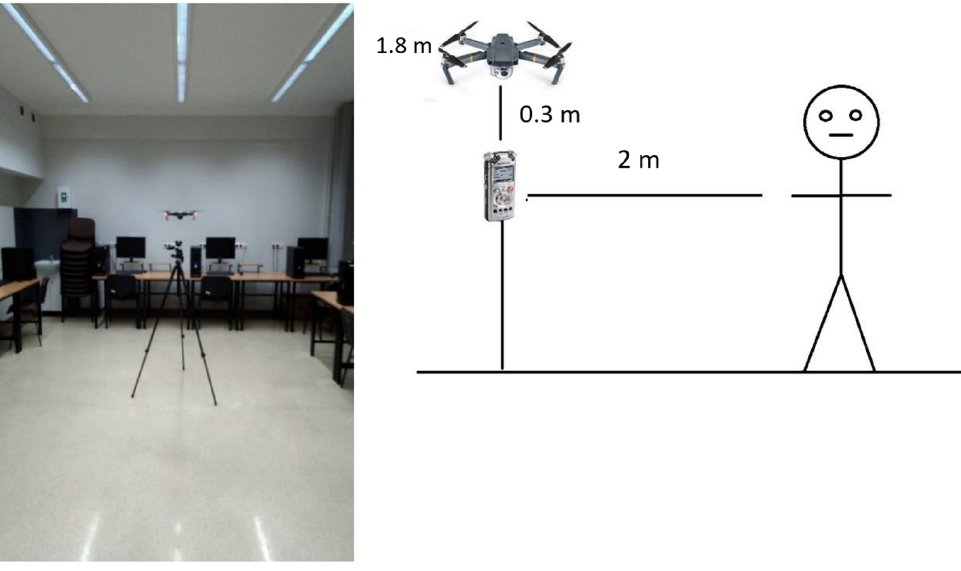
Figure 3. Measurements of speech